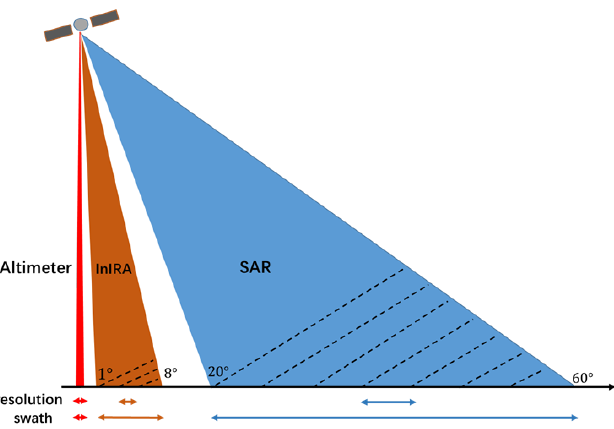
Figure 1. Schematic diagram of the resolution and swath of an altimeter, interferometric imaging radar altimeter (InIRA) and synthetic aperture radar (SAR) (the sketch does not represent the actual geometrical size).